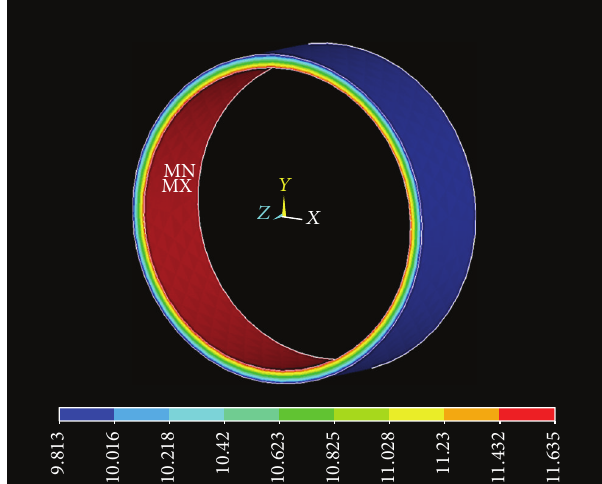
Figure 2: Stress distribution of an uncorroded oil pipe with internal